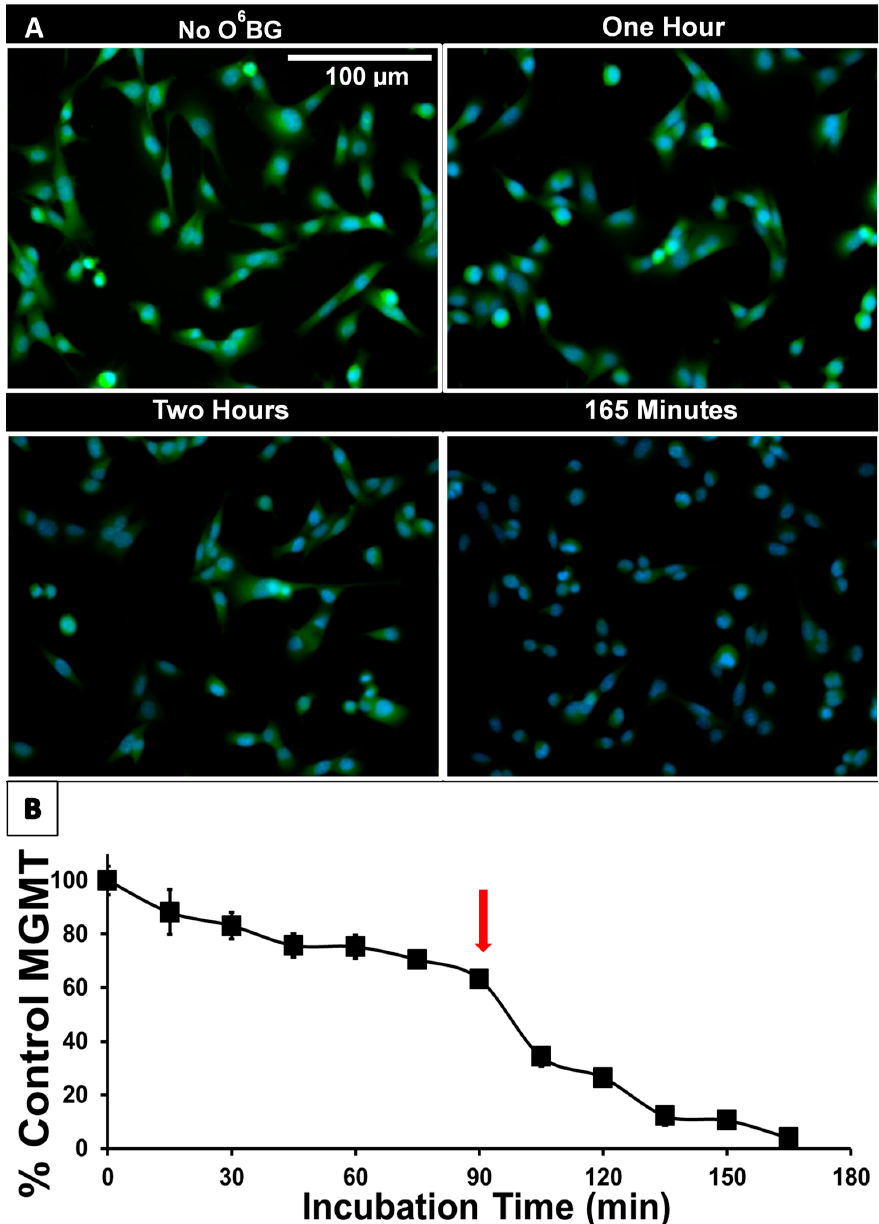
Figure 2. ( A ) Reduction of active MGMT upon incubation of GBM157 cells with 10 µM O 6 BG visualized with O 6 -propargyl (O 6 PGG) clicked with azido-PEG-FITC. ( B ) Quantification of fluorescence intensity shows a sharp reduction in active MGMT levels after about 90 min, indicated by the red